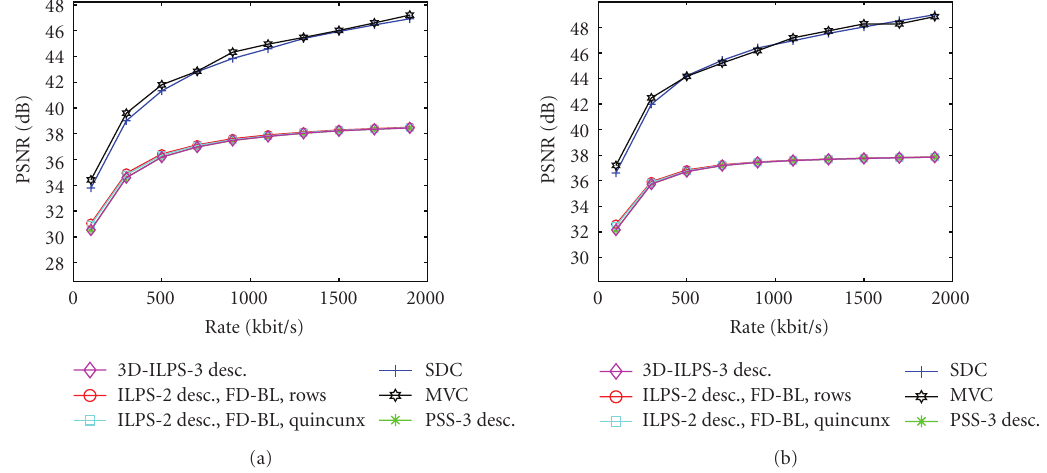
Figure 9: Performance of left view, three subsequences received. (a) Breakdance. (b)